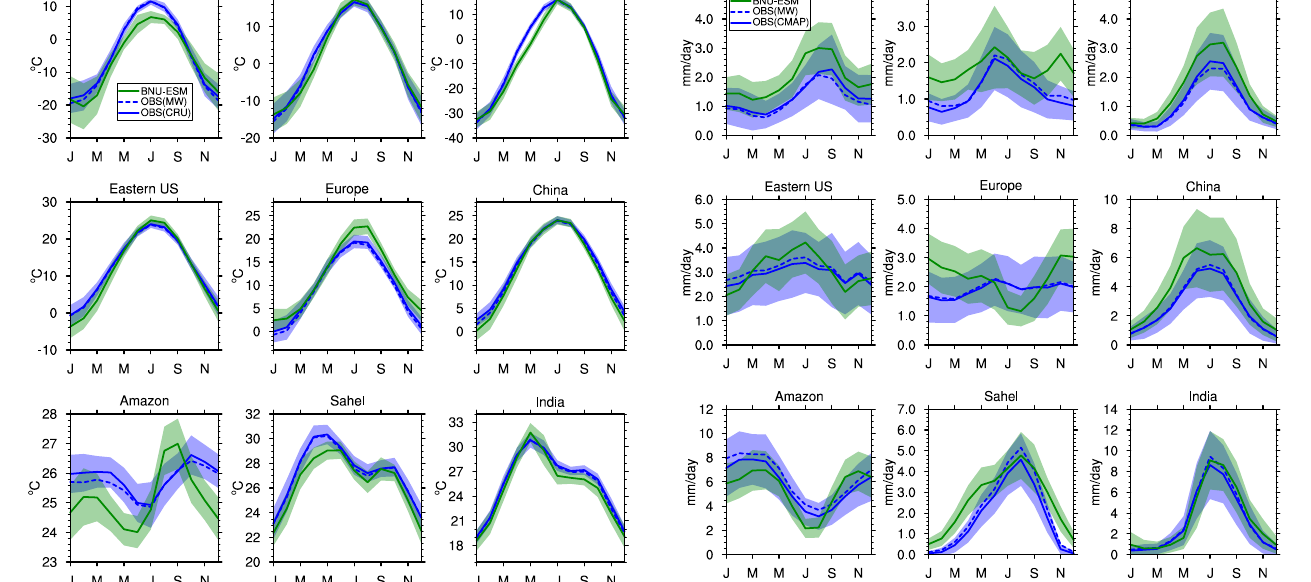
Figure 6. Climatological annual cycle of 2m air temperature for selected regions for BNU-ESM and two observational estimates for the period 1976–2005. Color shading indicates interannual vari- ability (standard deviation). MW denotes version 2.01, 0.5 ◦ × 0.5 ◦ monthly time series from Matsuura and Willmott (2009a). CRU is the Climatic Research Unit 0.5 ◦ × 0.5 ◦ TS 3.1 data set (Harris